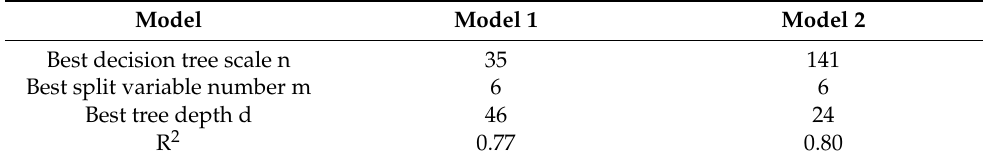
Table 5. Model parameters